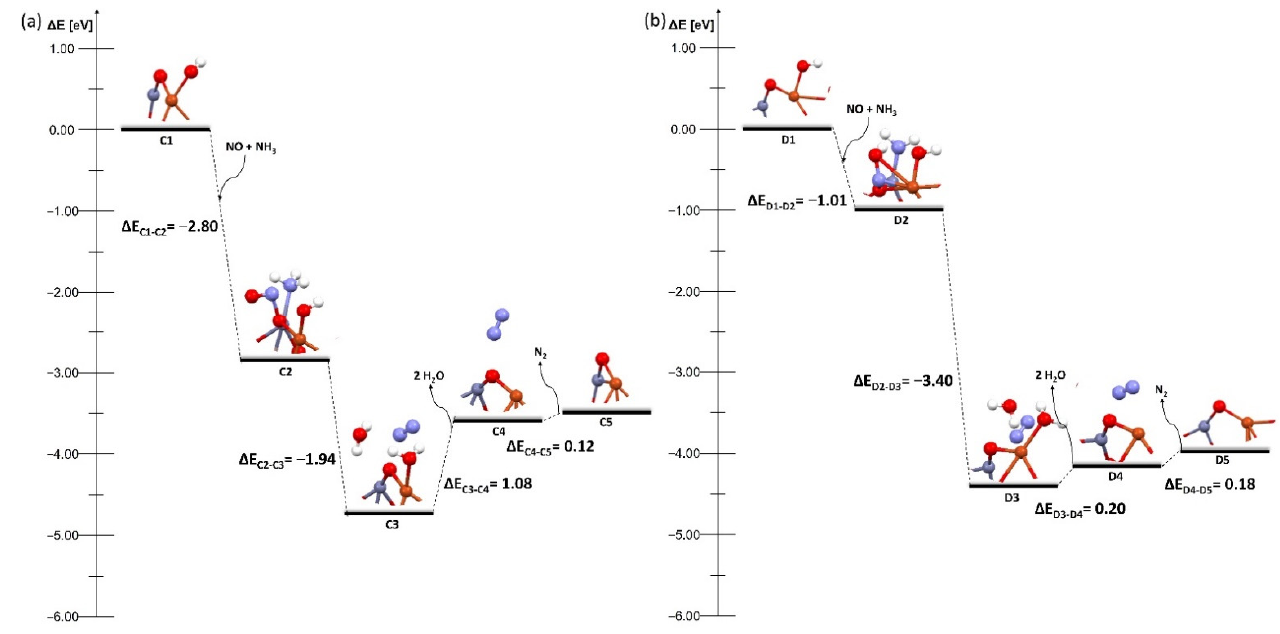
Figure 5. Energy diagram of proposed mechanism of deNOx in the Cu–O–Zn dimer supported on ( a ) bimetallic dimer on FAU and ( b ) bimetallic dimer on MFI with OH group on Cu on both zeolites.